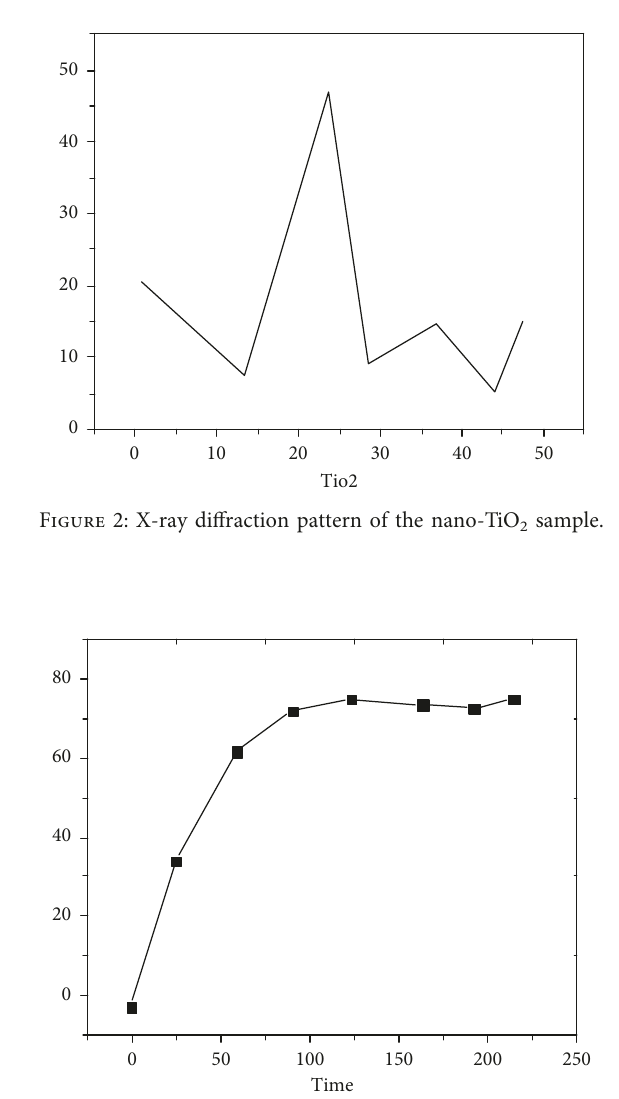
Figure 3: Influence of different loadings on formaldehyde deg- radation rate of photocatalytic